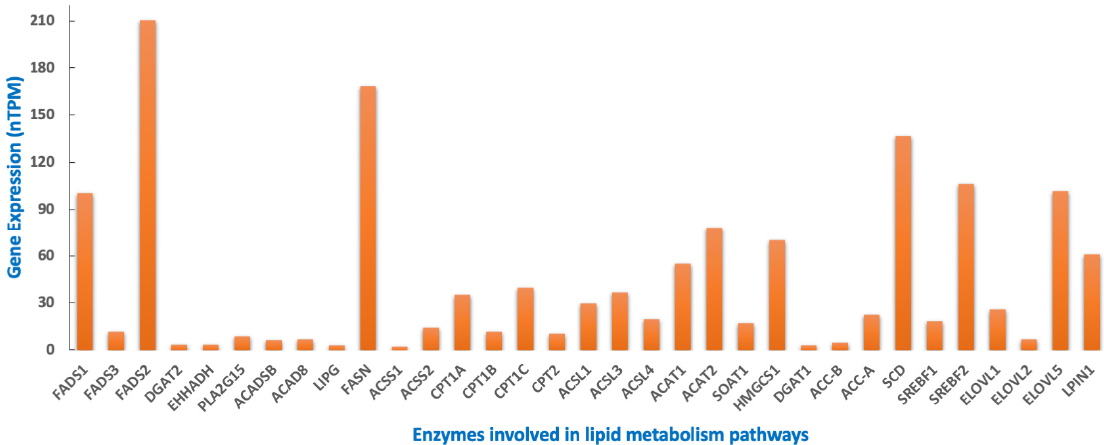
Figure 3. Gene expression profile of lipid metabolic enzymes in Neuroblastoma. The median expression of various lipid metabolic enzymes found in neuroblastoma was retrieved from Human Protein Atlas [150,151]. nTPM—number of transcripts per million; nTPM > 1 is considered to be a